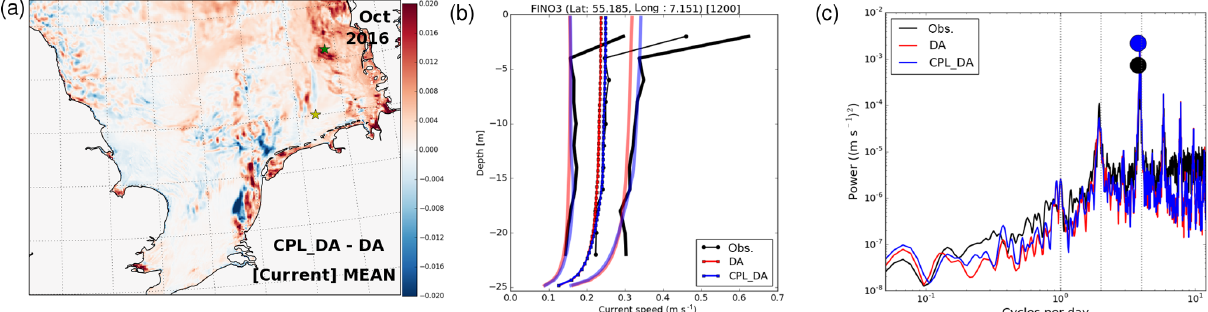
Figure 17. (a) Zoom of monthly mean differences in simulated surface current speed in CPL_DA relative to DA during October 2016 across the southern North Sea. (b) Monthly mean profiles of observed (black) and simulated (red, blue) current speed at the FINO3 location (green star) valid at 12:00UTC each day during October 2016. Mean profiles are plotted with symbols, and thick lines indicate 1 standard deviation range from mean profiles. (c) Computed power spectra for observed, DA and CPL_DA simulated current speed at 4m depth during October 2016. Filled circles highlight the amplitude of the peak power for each time series (note DA and CPL_DA maxima are identical). Vertical dotted lines mark diurnal, semi-diurnal, and quarter-diurnal